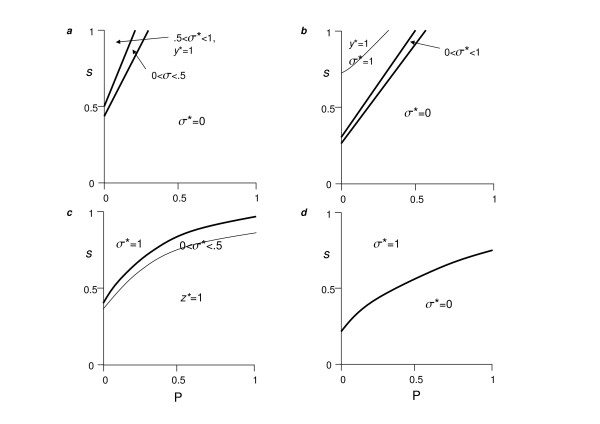
Globally optimal associations in dispersal and exploitation strategy for Model 1. Axes: P measures the impact of the public good on individual fitness, and s is the individual cost to cooperators in contributing to the public good. σ * = y*/(z* + y*) indexes the tendency of cooperators to disperse (σ* > 0.5) or cheats to disperse (σ* < 0.5). Thick curves demarcate areas of parameter space yielding different levels of σ, whereas thin lines show areas in with either y* = 1 or z* = 1. Caption a: k = 1.2, n = 0.1; caption b: k = 10, n = 0.1; caption c: k = 1.2, n = 0.9; caption d: k = 10, n = 0.9. Note that for legibility, very thin areas parallel to thick lines are omitted, in which 0.5 < σ* < 1 for caption c, and 0 < σ* < 1 for caption d. Unless otherwise noted, dispersal rates are greater than zero and less than unity. Other parameters: c = e = 0.2, Q = 0.2. See main text for numerical methods.